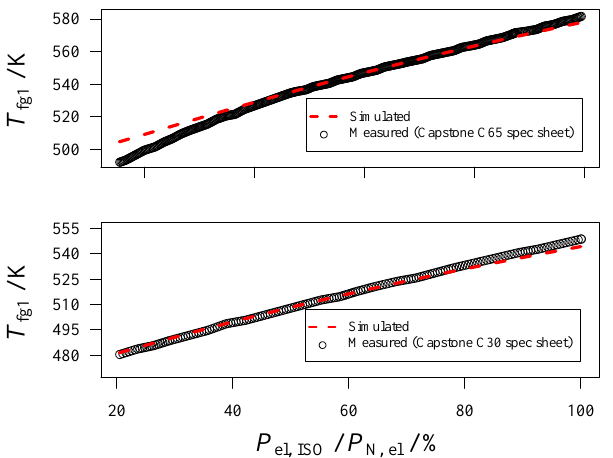
Figure 7. ( Top ) Flue gas temperature at the outlet of the MGT vs. electrical load of the Capstone C65 MGT with a nominal electrical power of 65kW; ( Bottom ) Flue gas temperature at the outlet of the MGT vs. electrical load of the Capstone C30 MGT with a nominal electrical power of 30kW. In both the cases, the relative discrepancy on the Kelvin temperature scale was less than 1% for a part load operation higher than